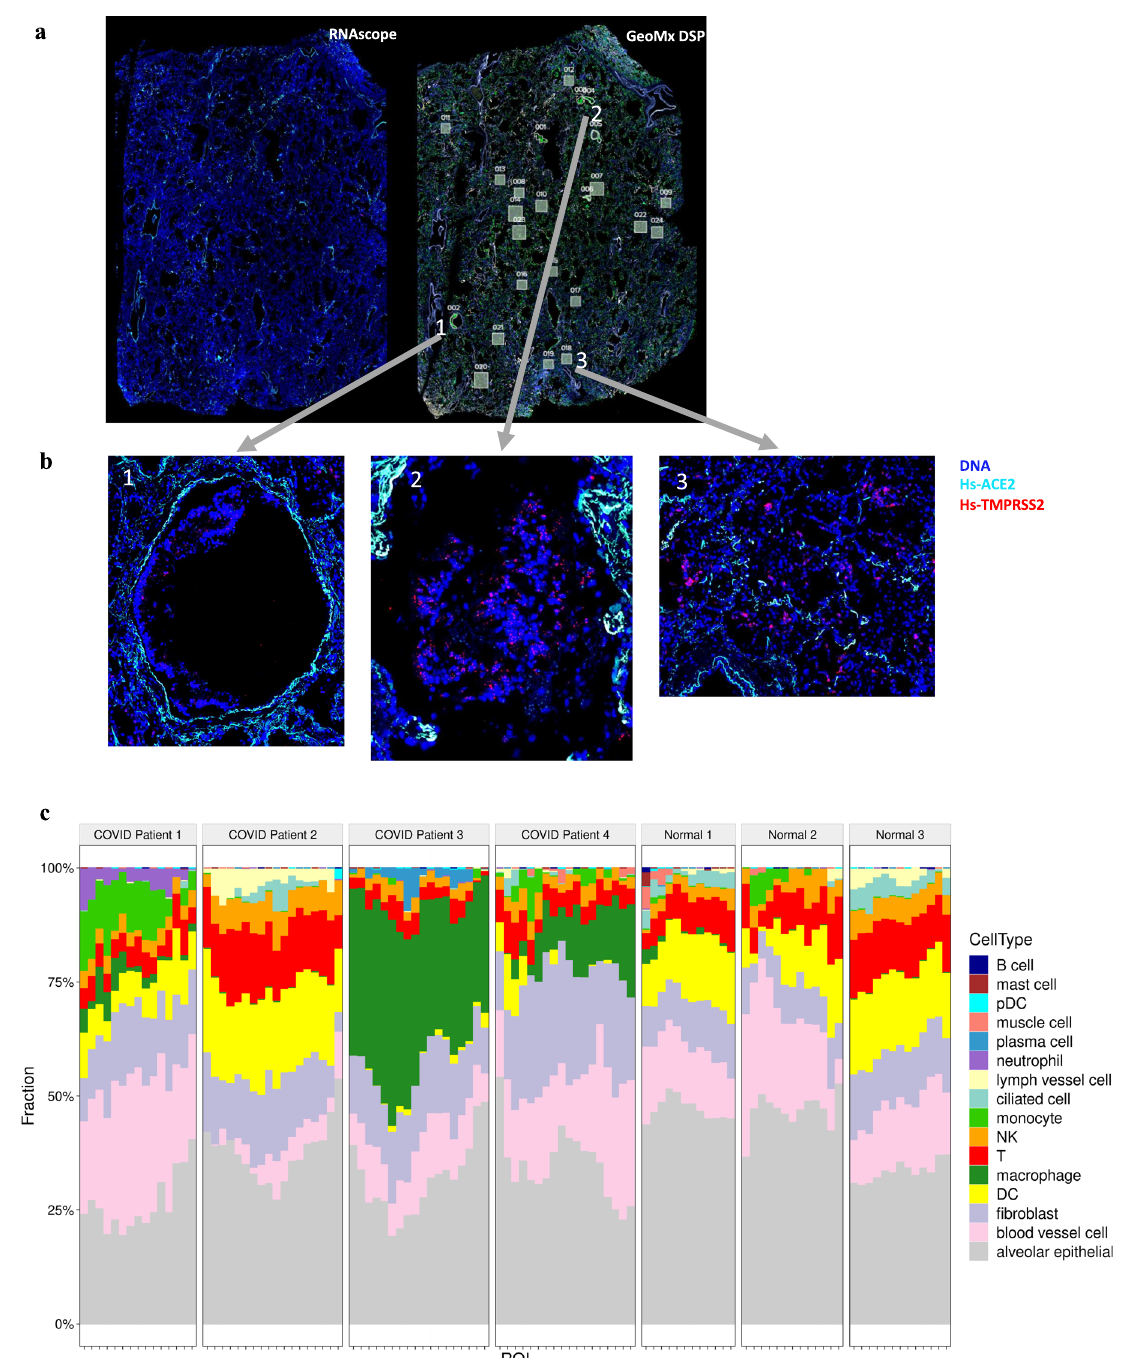
Fig. 6 Spatial transcriptomic pro fi les of patient autopsies. a Imaging from RNAscope showing fl uorescence of target genes and imaging from GeoMx DSP de fi ning regions of gene expression measurement for COVID Patient #4. b Close up of few selected regions of interest (ROI). c Cellular composition of 107 tissue regions. Each column shows the cell proportions within a single alveolar segment, as estimated from mixed cell deconvolution of GeoMx RNA data. Controls are from excess lung material from healthy lung transplant